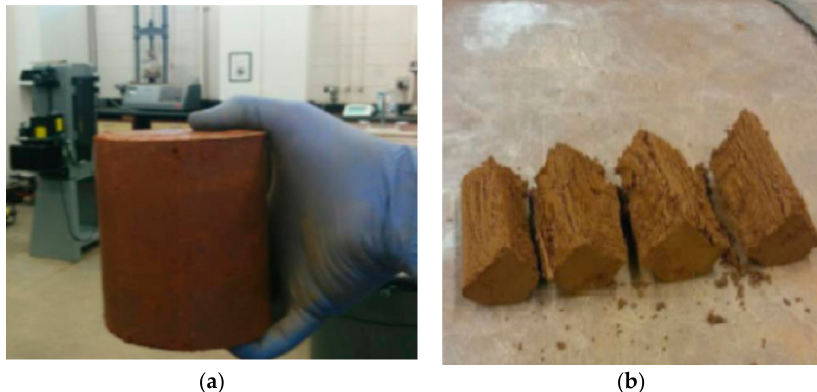
Figure 5. Typical specimen appearance ( a ) before and ( b ) after the unconfined compression strength (UCS) test.